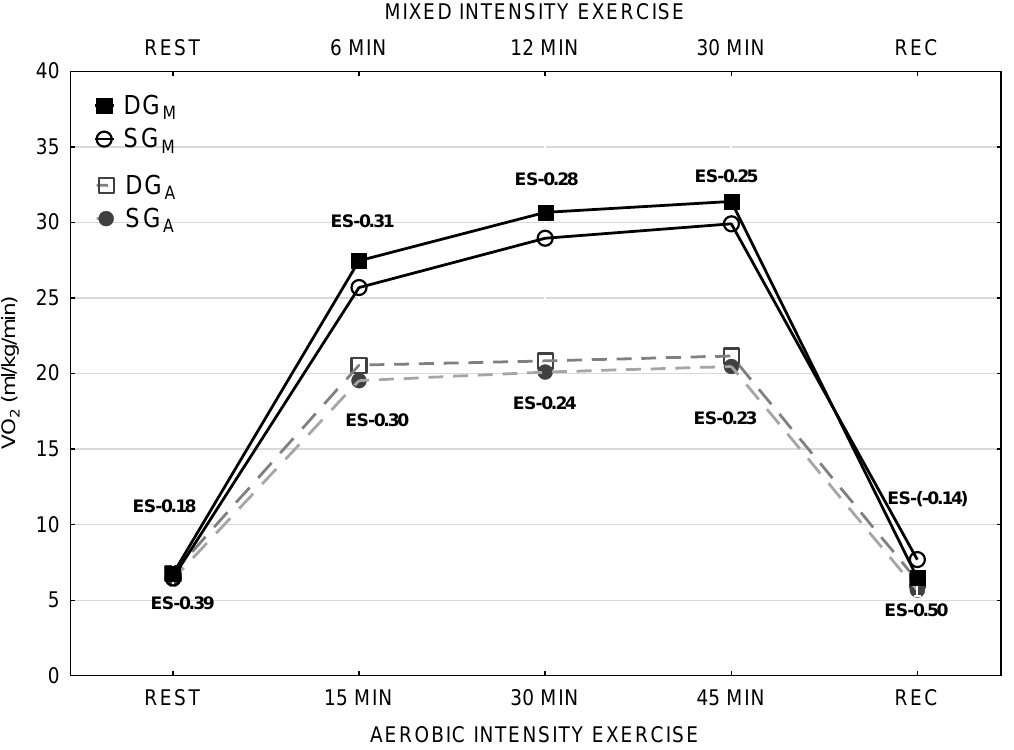
Figure 1. The volume of oxygen absorbed by patients from DG and SG groups during aerobic and mixed intensity exercise. Table 2. Clinical and biochemical comparison of deficient (DG) and suboptimal (SG) 25(OH)D serum